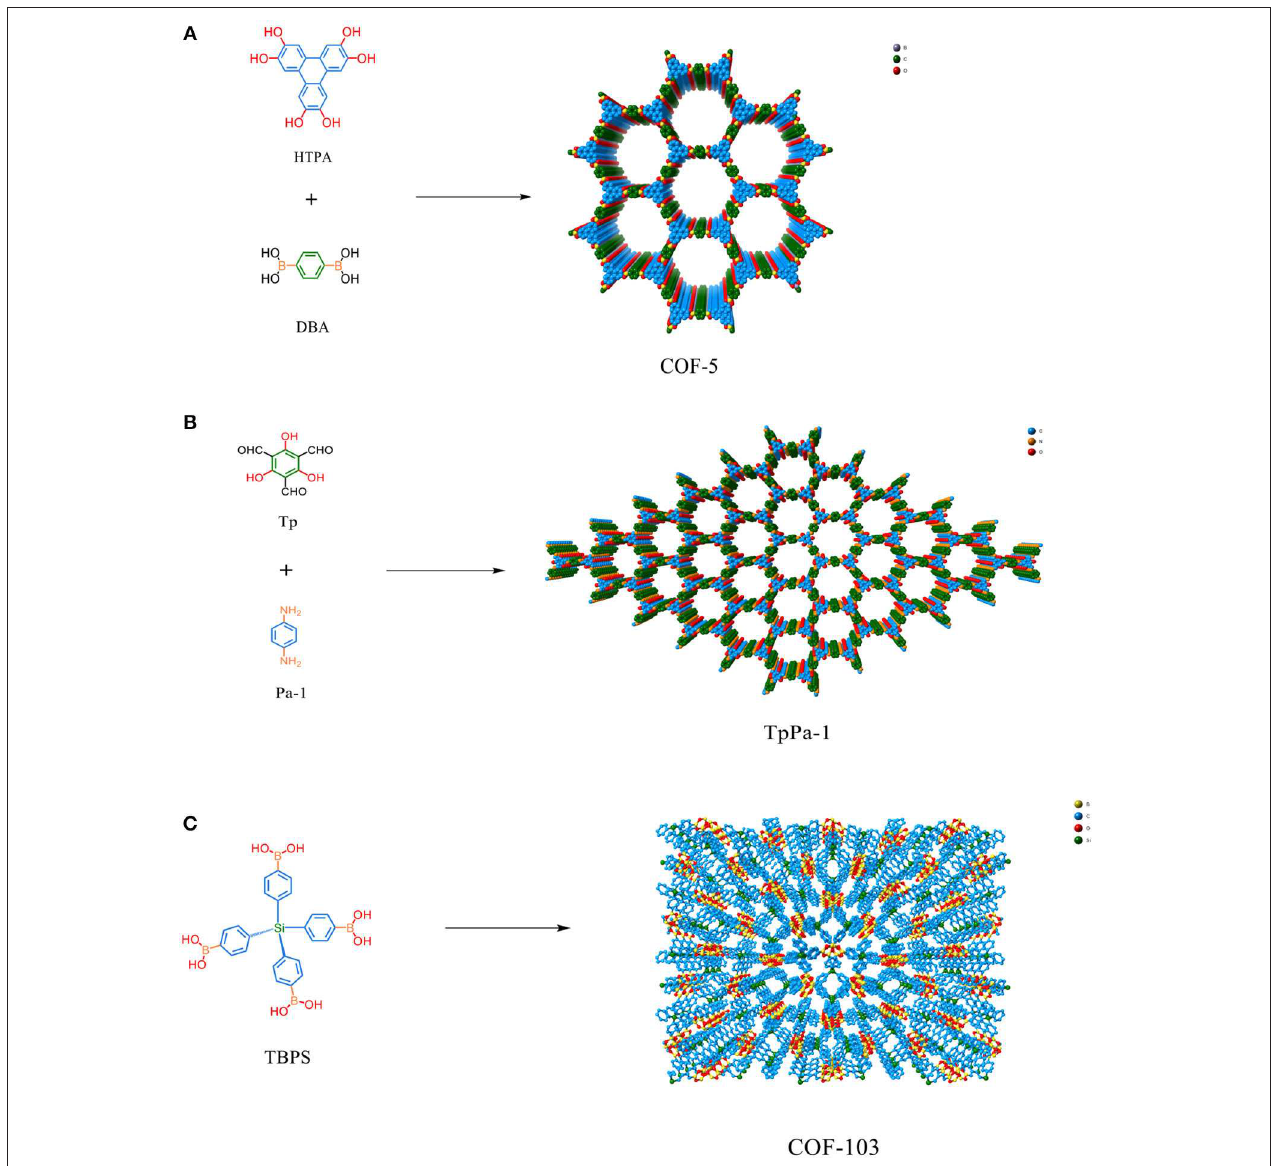
FIGURE 1 | (A) Structure and composition of COF-5 ( Table 1 entry 2). (B) Structure and composition of TpPa-1 ( Table 1 entry 17). (C) Structure and design of COF-103 ( Table 1 entry 7).